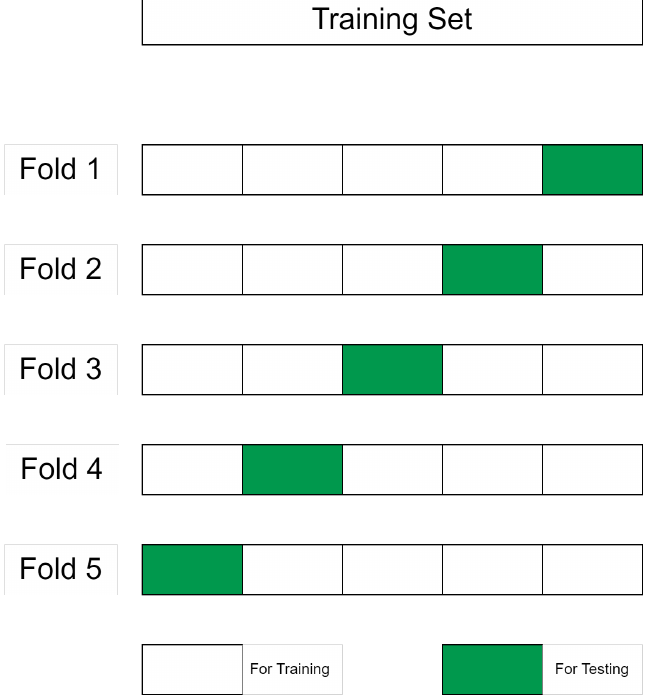
Figure 10. Kfold cross-validation mechanism: in each iteration, a part of the dataset is used for testing the model while the rest is used for training the model independently. In other iterations, another part is used for testing, and so on